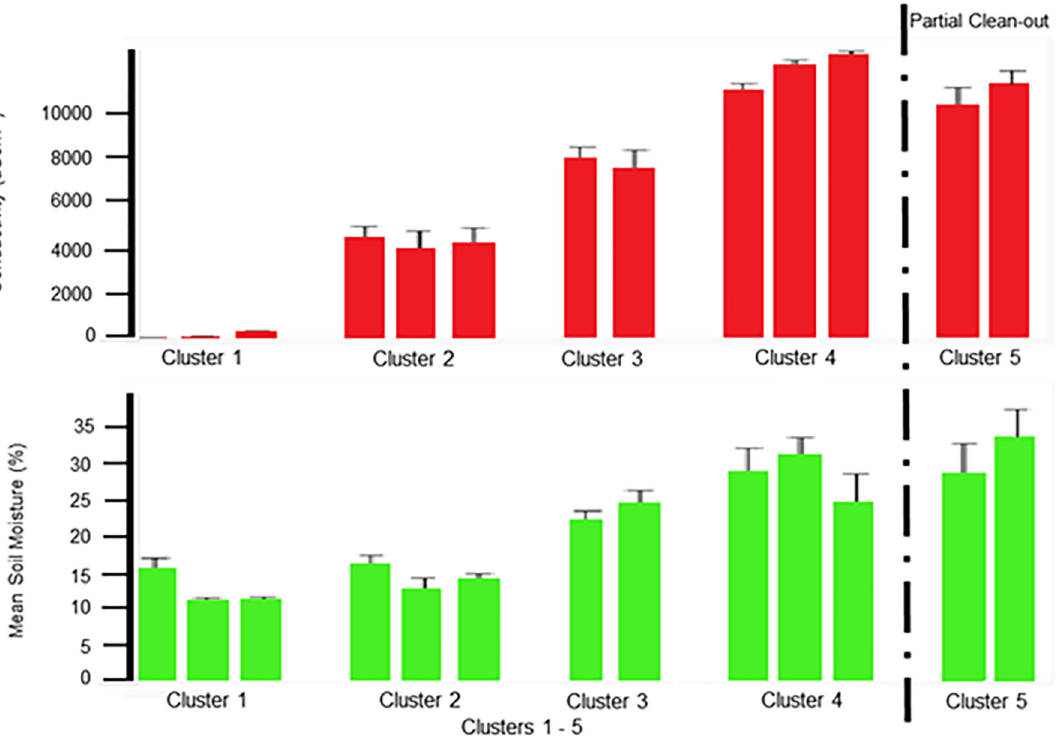
Fig 3. Mean values for Electrical Conductivity. Mean values for Electrical Conductivity, expressed as μ Scm -1 , with standard deviation error bars are shown in the top graph. Mean values for Soil Moisture, expressed as a percentage, with standard deviation error bars are shown in the bottom graph. In order from left to right on the graph is Cluster 1: Native, Pad and Flock1; Cluster 2: Flock 2, 10 and 11; Cluster 3: Flocks 3 and 4; Cluster 4: Flocks 5, 6, and 7; and Cluster 5: Flocks 8 and 9. The partial clean-out which occurred between Flock 7 and 8 is marked by a dashed